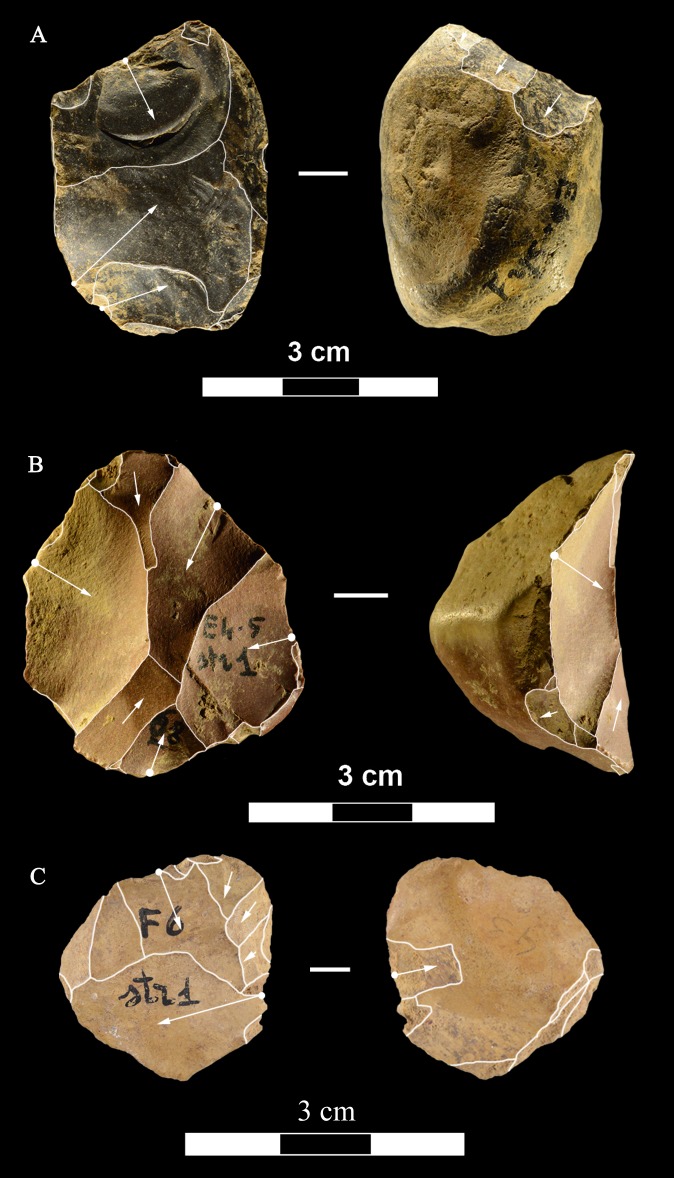
La Fabbrica, Mousterian cores from layer 1.(A) Bidirectional core of uncertain Levallois character on a flint pebble; note the partial platform preparation and presence of convexities on two sides only. (B) Centripetal (non-Levallois) core with a single debitage surface on a jasper pebble, front and left side view. (C) Core of recurrent Levallois type on a chert pebble; the last scar is invasive and seems to have removed the convexities. L of A, B, C: 39, 40 and 23 mm. Catalogue numbers: 7, 5 and 22.